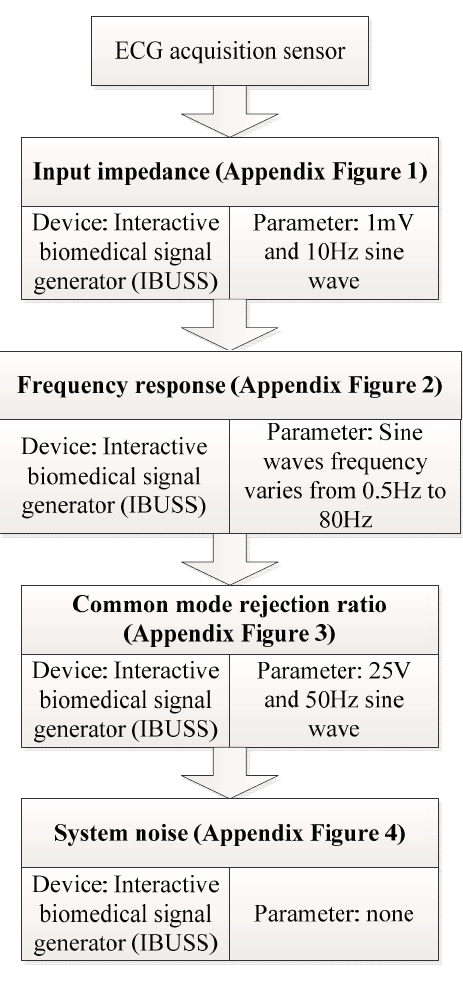
Figure 8. ECG acquisition sensor hardware validation